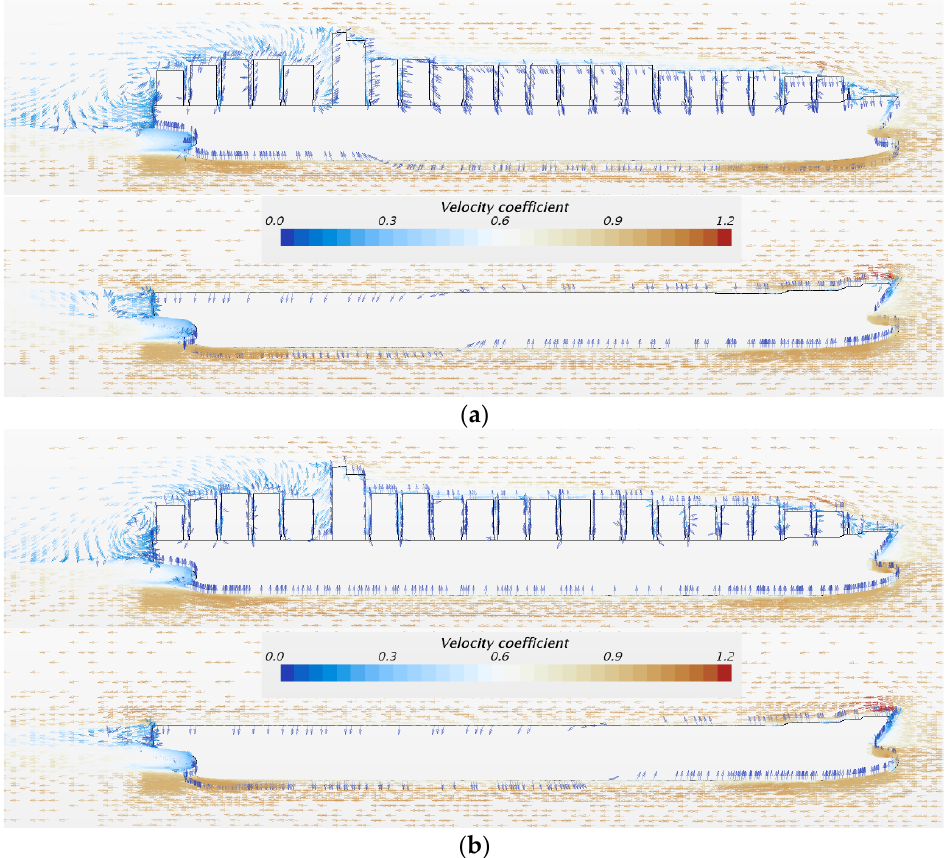
Figure 8. Velocity vector around the 8000 TEU-class container ship (velocity coefficient was defined as velocity divided by the inlet velocity). ( a ) 𝐹 𝑁 0.165 and ( b ) 𝐹 𝑁 0.274.